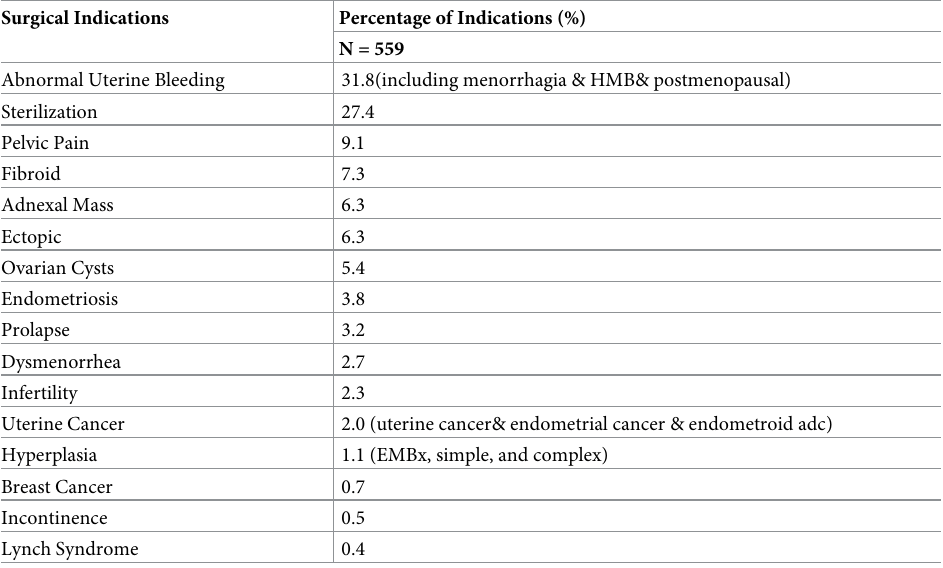
Table 2. Demographics and indications for surgery in all patients.